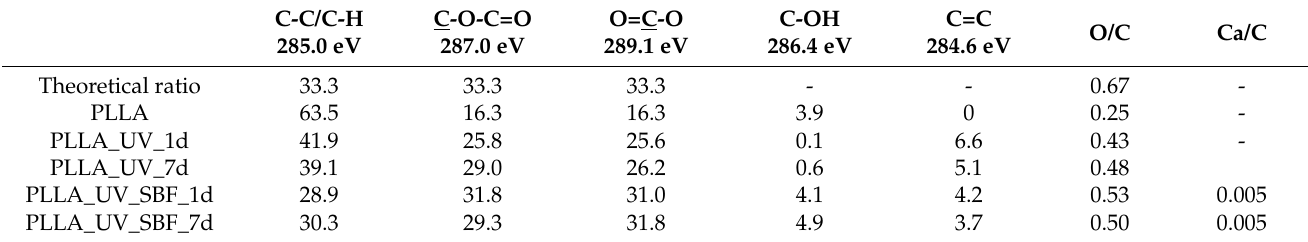
Table 2. Fraction of carbon functional groups from the high-resolution C 1s XPS peak on the surface of pristine PLLA, after laser irradiation and treatment in